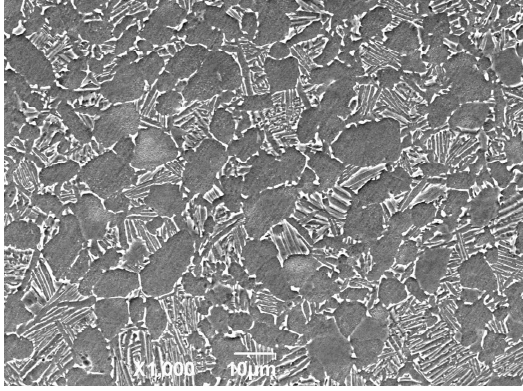
Figure 1. The microstructure of the annealed-state Ti-6Al-4V alloy.